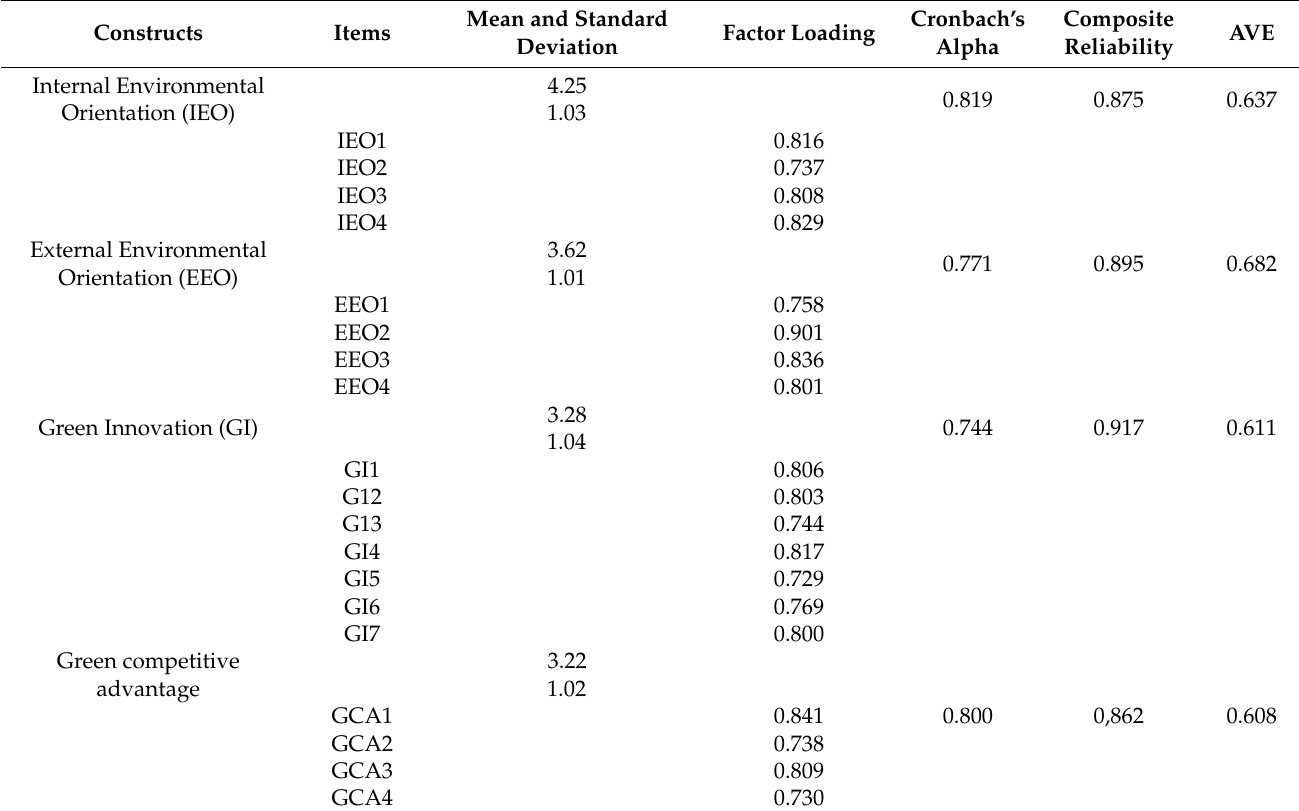
Table 2. The measurement